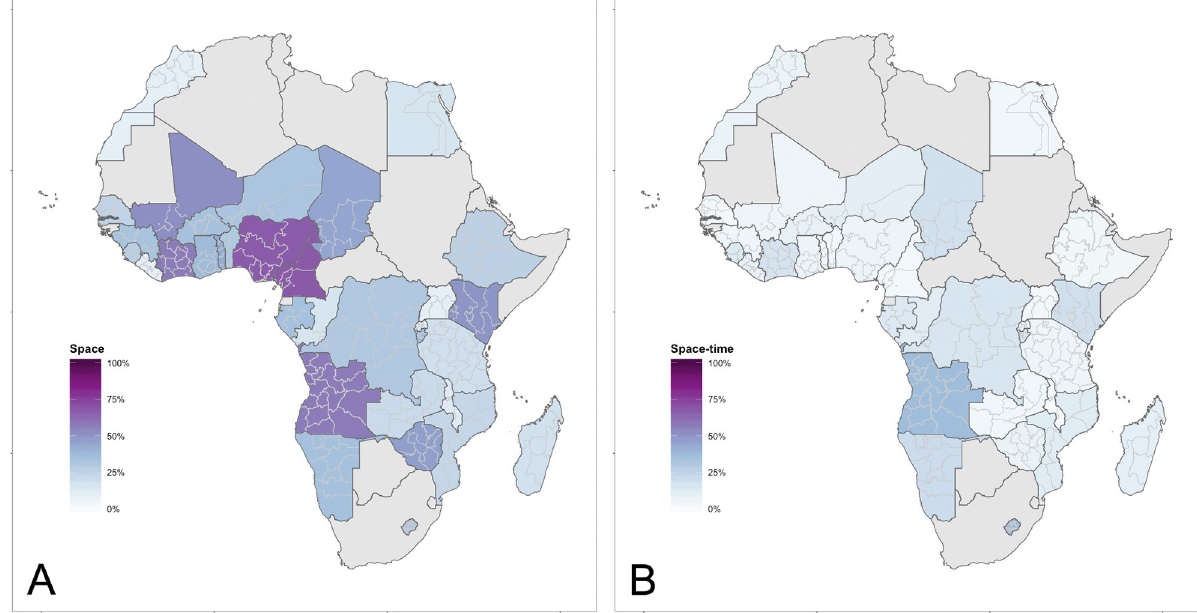
Fig 1. Africa: Proportion of variation explained by effects involving space. A: Spatial Variation. B: Space × time interaction variation.